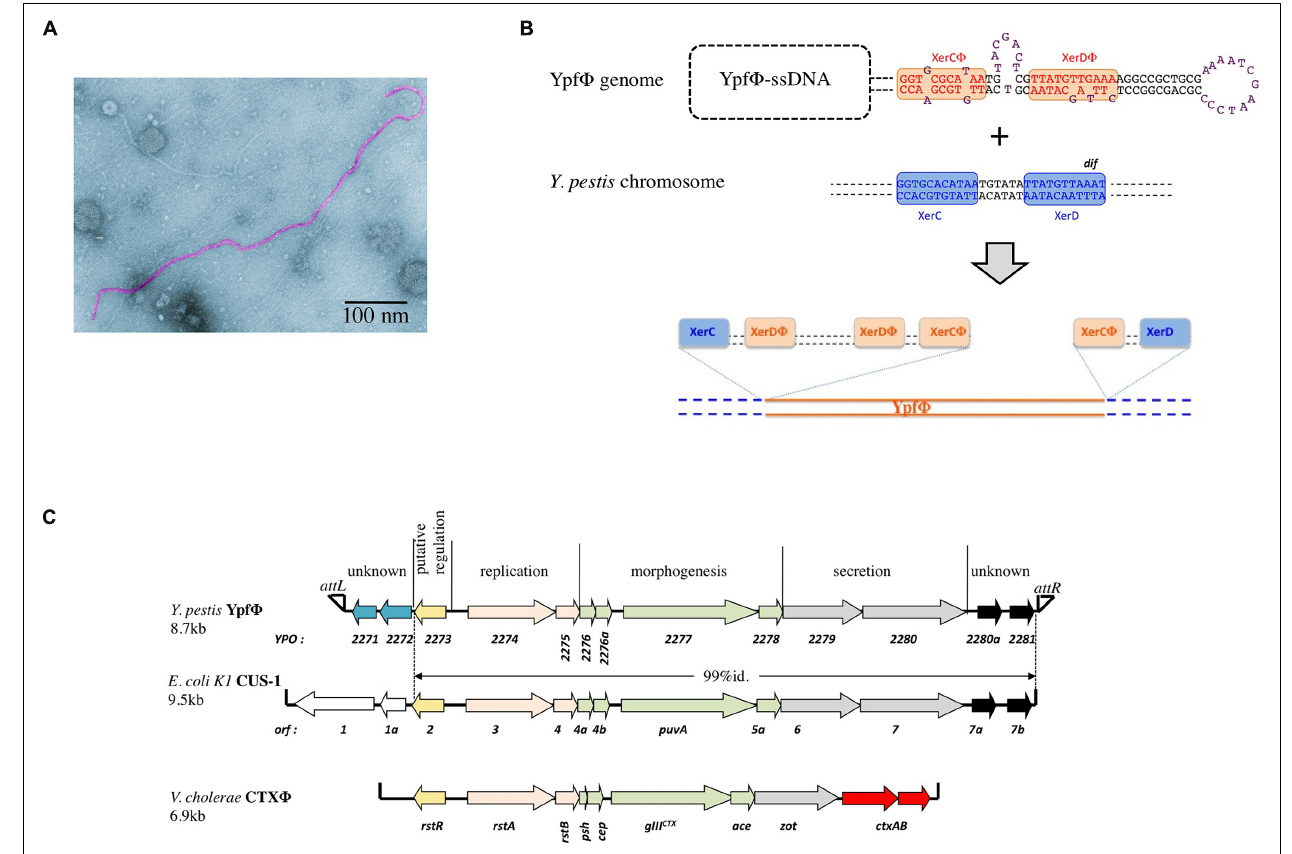
FIGURE 1 | (A) Electronic micrograph ofYpf (cid:2) . (B) Schematic representation of the proposed XerC-dependent phage integration into the chromosomal dif site of Yersinia pestis. (C) Ypf (cid:2) , CUS-1 and CTX-1 genomic organization.